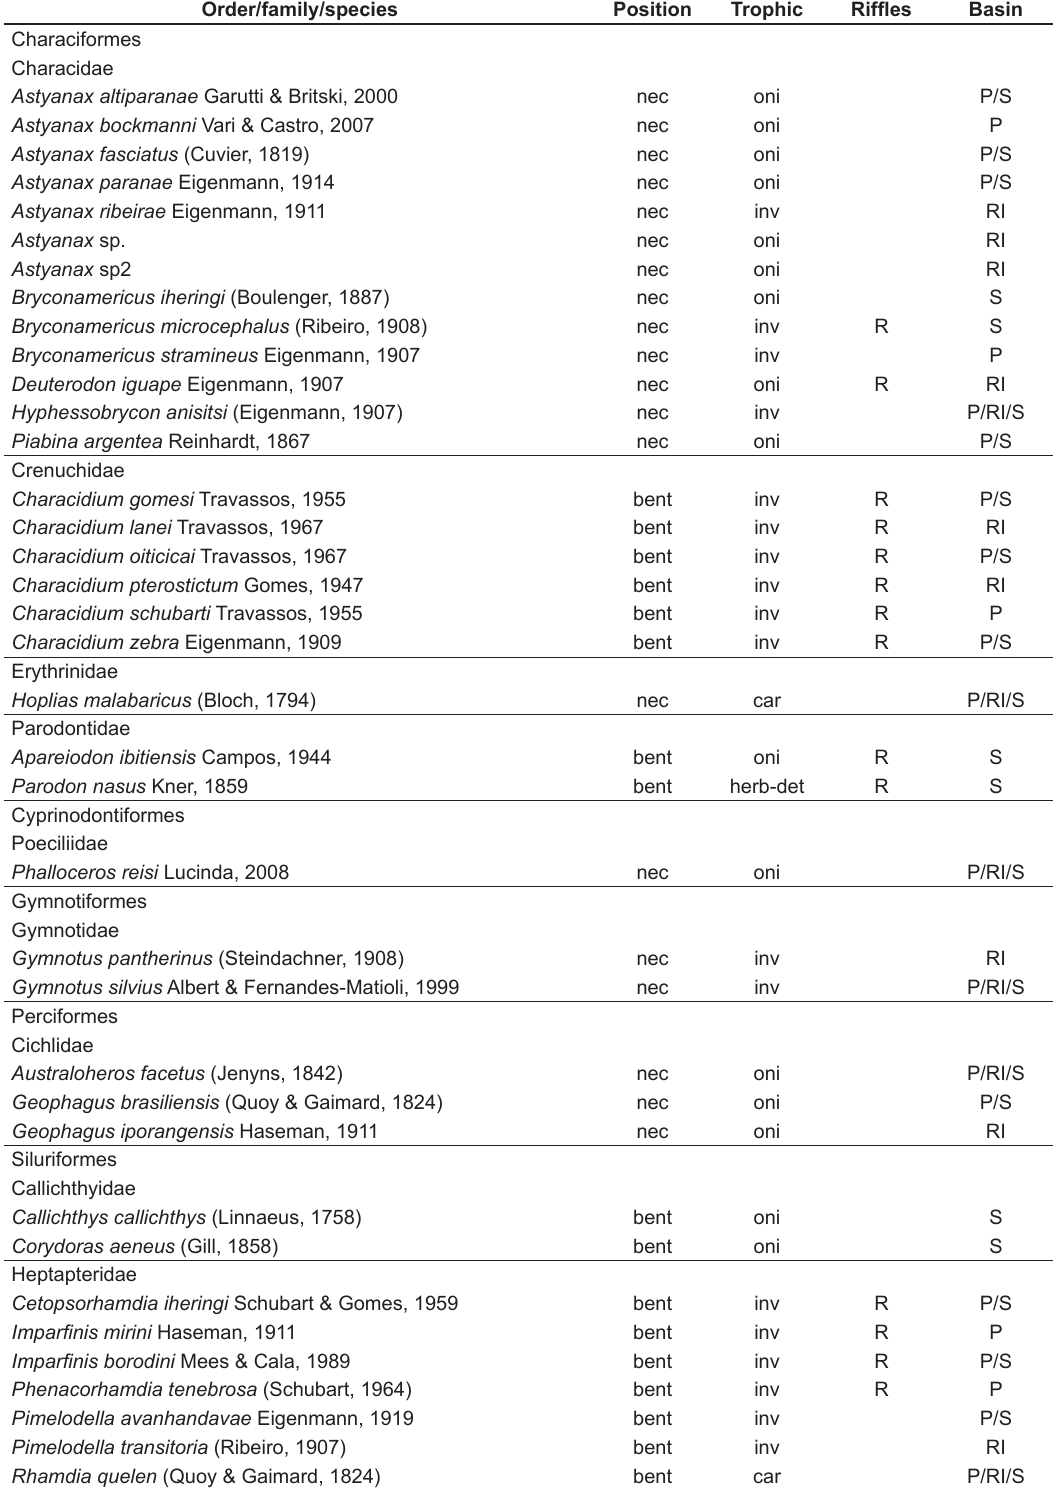
Table 2. Classification of sampled species according to attributes related to position in the water column. Order/family/species Position Trophic Riffles